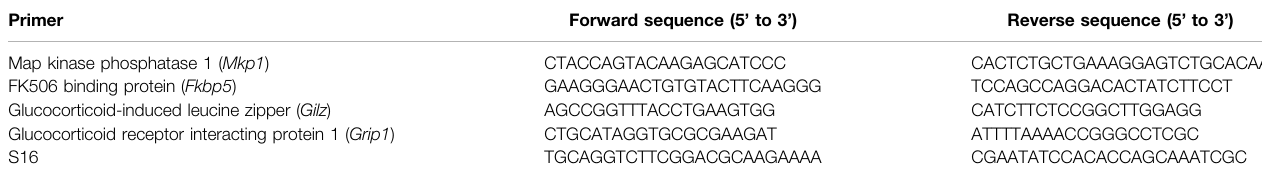
TABLE 1 | Primer sequences.